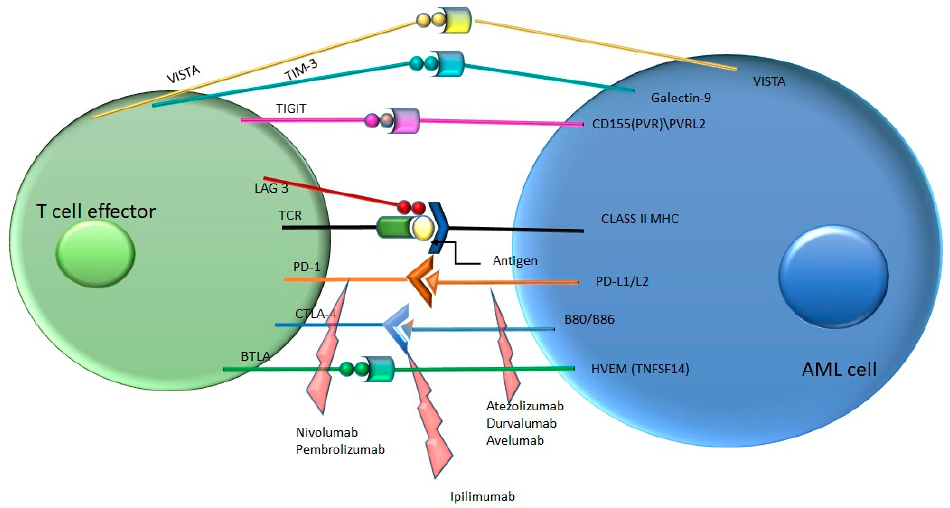
Figure 1. Immune checkpoint pathways and their inhibitors in acute myeloid leukemia (AML) (inhibitors—marked with red arrows). PVR—poliovirus receptor, PVRL2—poliovirus receptor-related 2, HVEM—herpesvirus entry mediator.